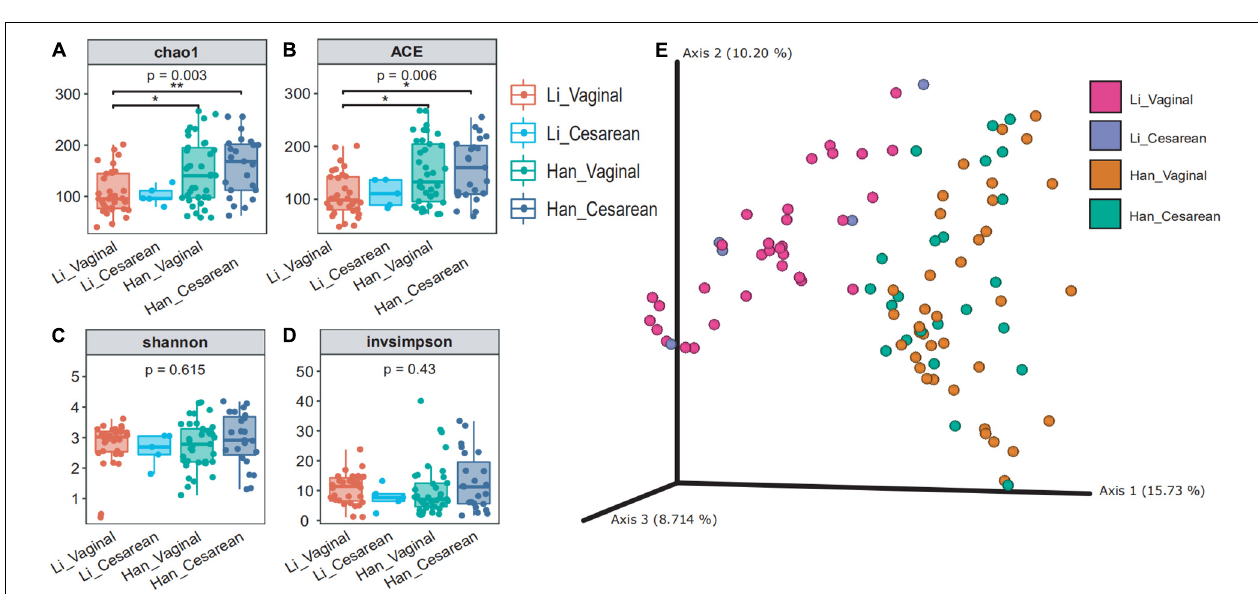
FIGURE 1 | The α diversity and β diversity of colostrum microbiota of two ethnic groups. The difference check box plot shows the alpha diversity between the Li and Han ethnic groups. chao1 (A) and ACE (B) can reflect the abundance, and Shannon (C) and invsimpson (D) can reflect the diversity between Li and Han’s mothers analyzed by 16S rRNA gene sequencing. (E) Principal coordinate analysis plot of Bray–Curtis distance.